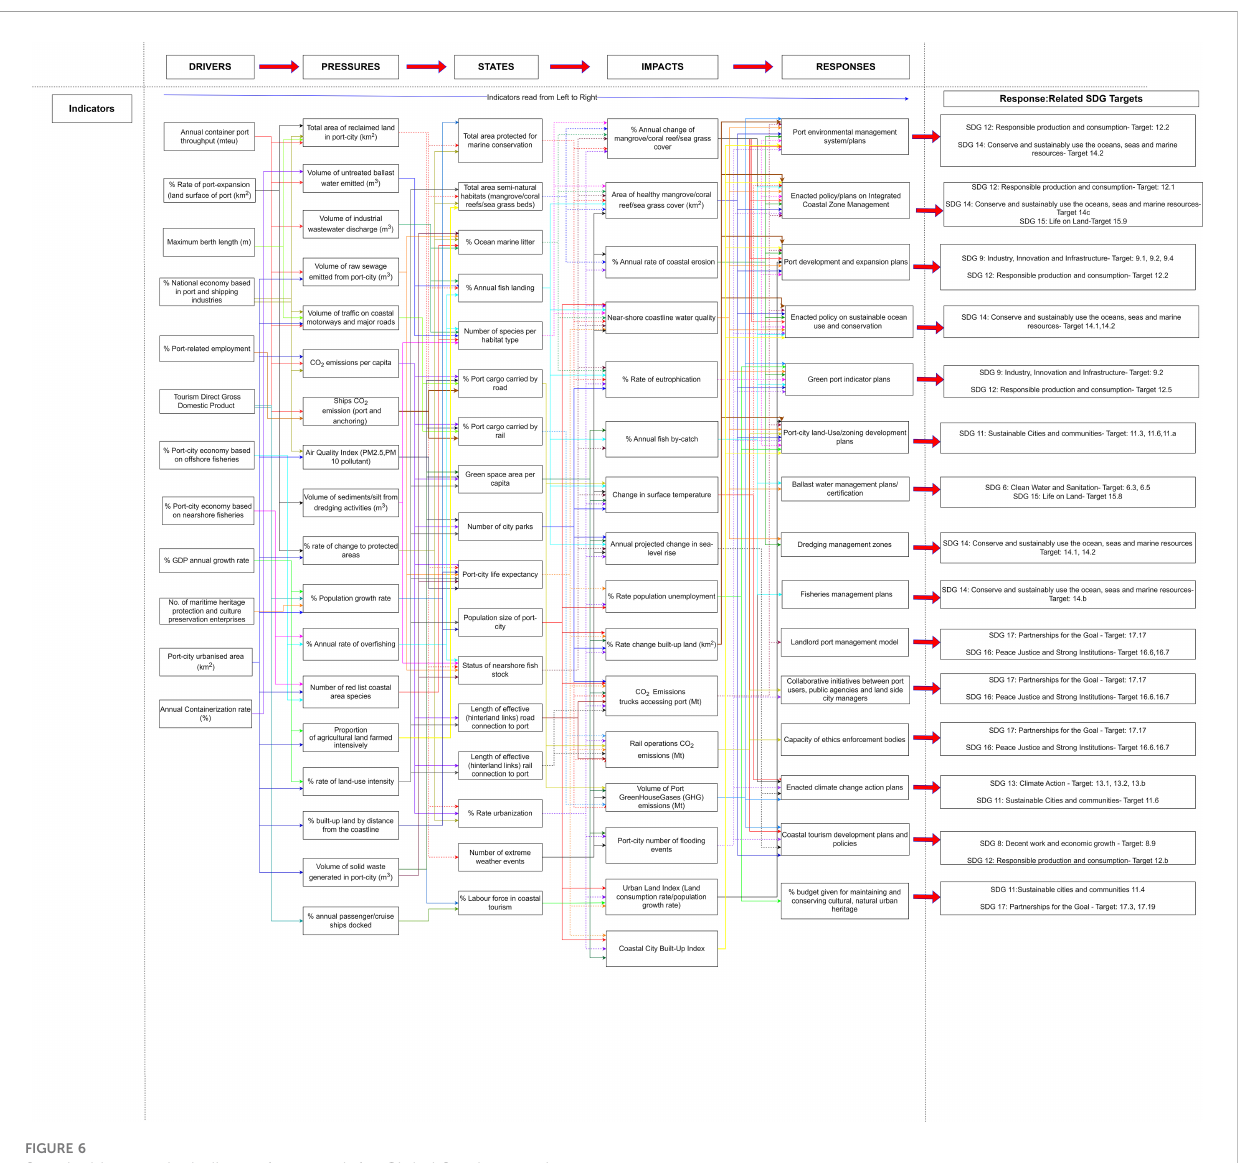
FIGURE 6 Sustainable port city indicator framework for Global South